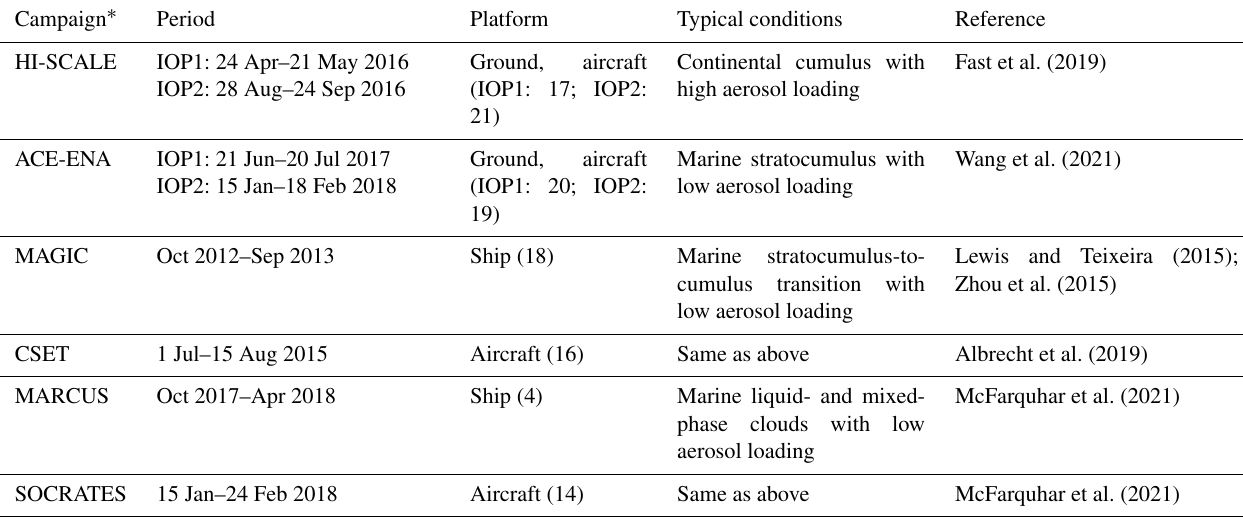
Table 1. Descriptions of the field campaigns used in this study. Numbers after an aircraft or ship represent the number of flights or ship trips in each field campaign or intensive operational period